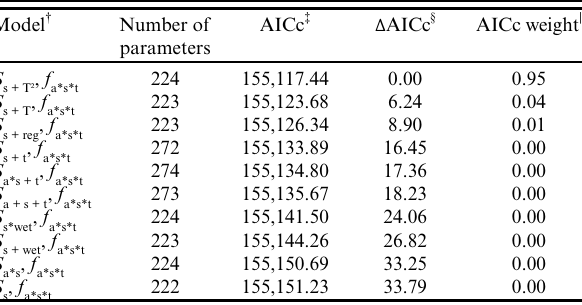
Table 1. Summary output from competing band-recovery models developed to estimate annual survival ( S ) and recovery ( f ) probabilities for Northern Pintail ( Anas acuta ) banded in Alberta and Saskatchewan (≤ 54° N latitude) during 1960–2014. Only the 10 top-ranked models based on the adjusted Akaike Information Criterion (AICc) are shown.